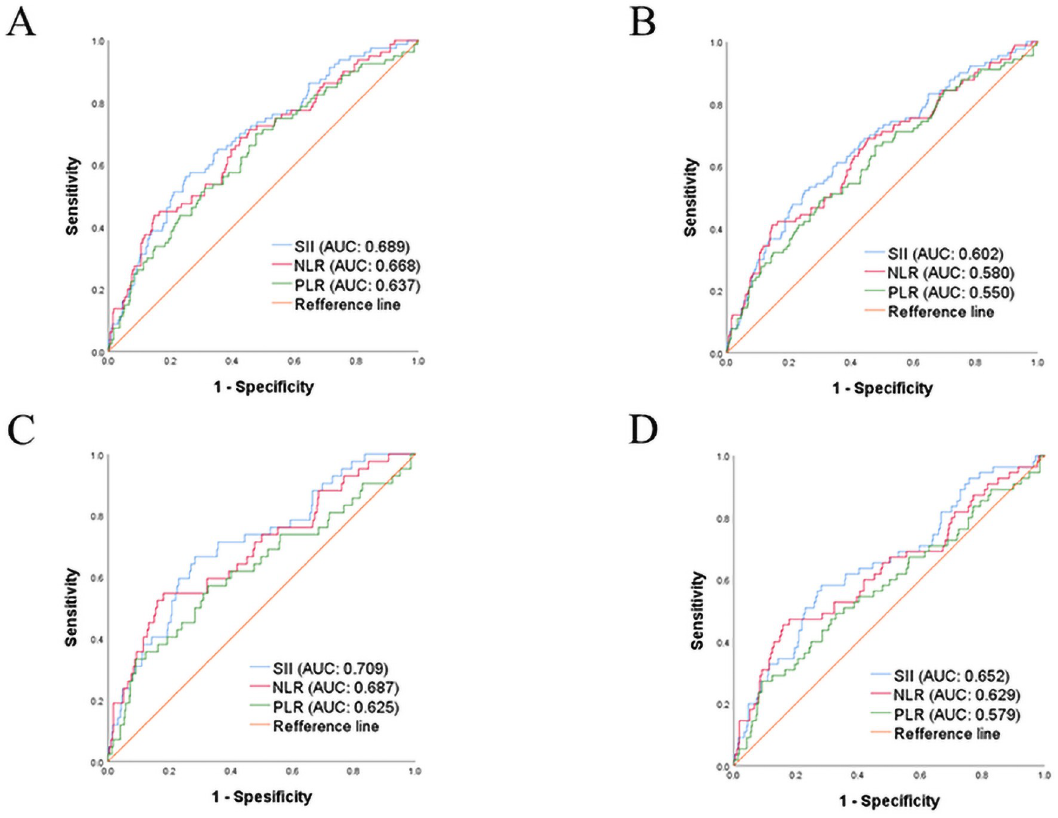
Fig 3. Comparison of the utility of the SII versus theta of the other inflammatory indexes. A, ROC curves for 3-years PFS. B, ROC curves for 5-years PFS. C, ROC curves for 3-years OS. D, ROC curves for 5-years OS.